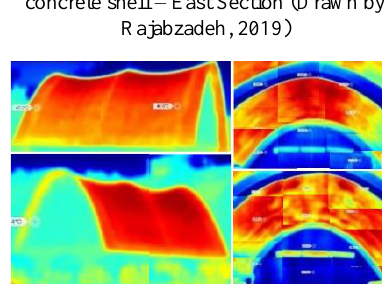
Figure 18. Series of sections showing the gap size between the roof membrane and the concrete shell – East Section (Drawn by Rajabzadeh, 2019)